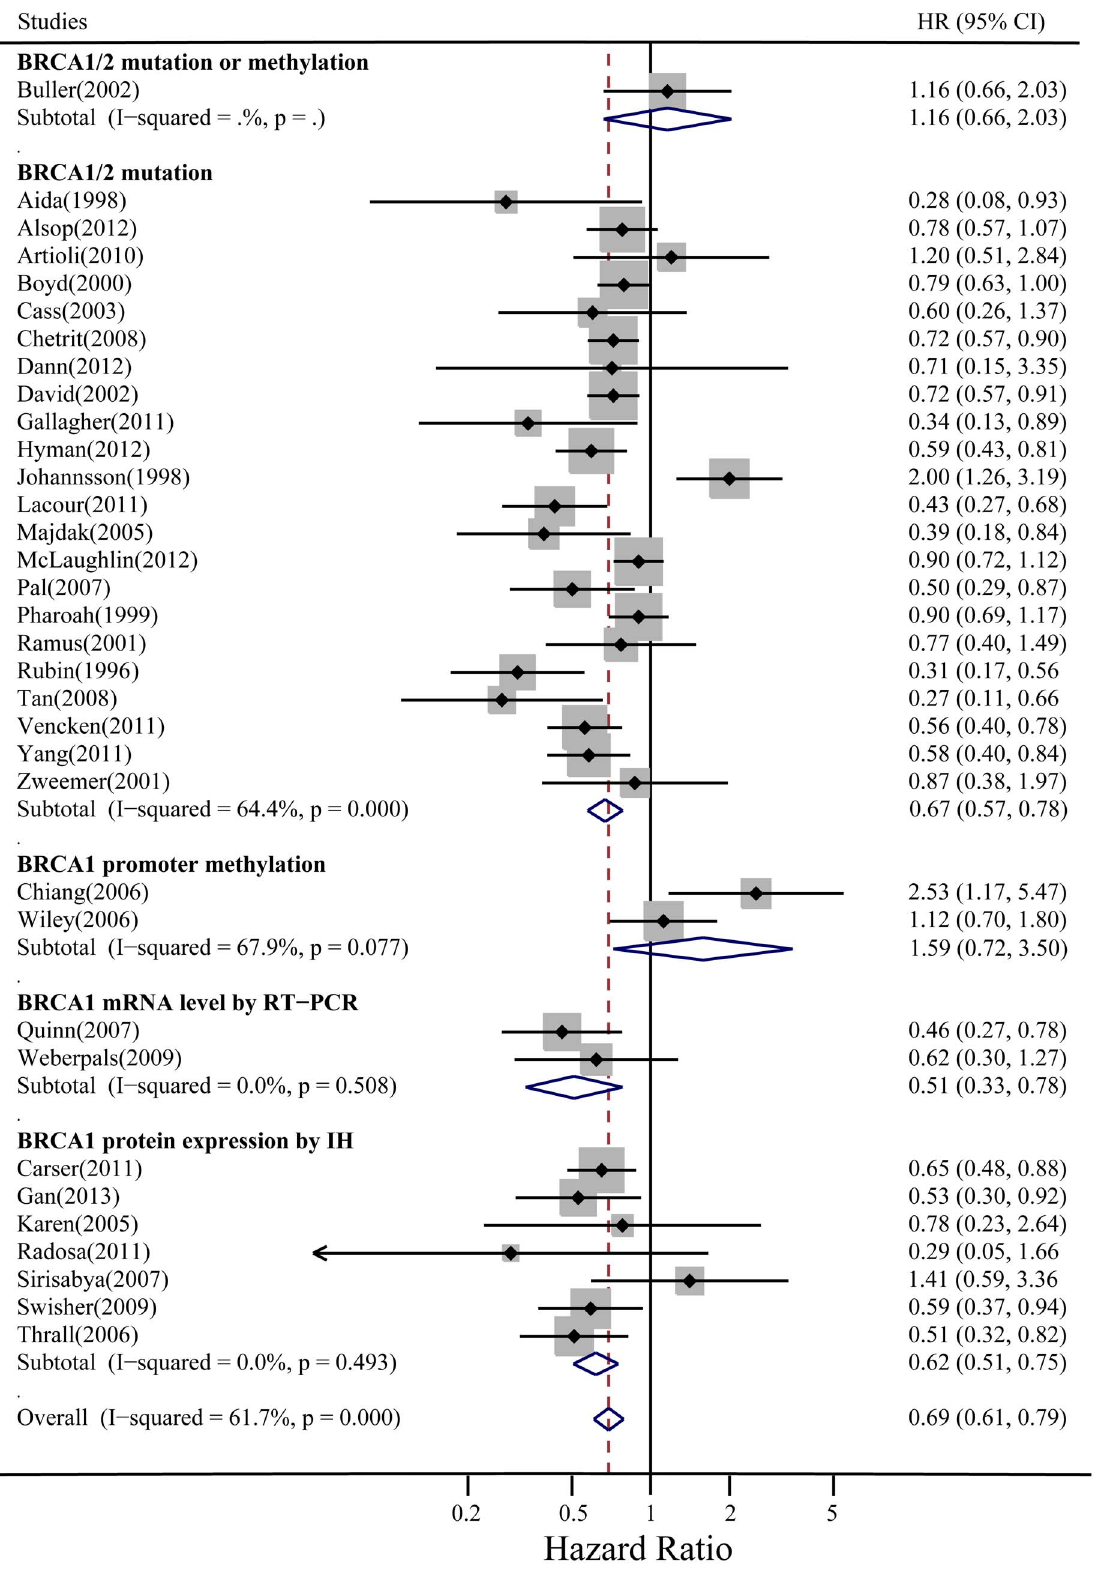
Figure 2. Summary hazard ratios (HRs) and 95% confidence intervals (CIs) of epithelial ovarian cancer OS for BRCA dysfunction status. Horizontal lines represent 95% CIs; diamonds represent summary estimates with corresponding 95% CIs. Test for heterogeneity: P =.000, I 2 =61.7%. A random-effects model was used for analysis.